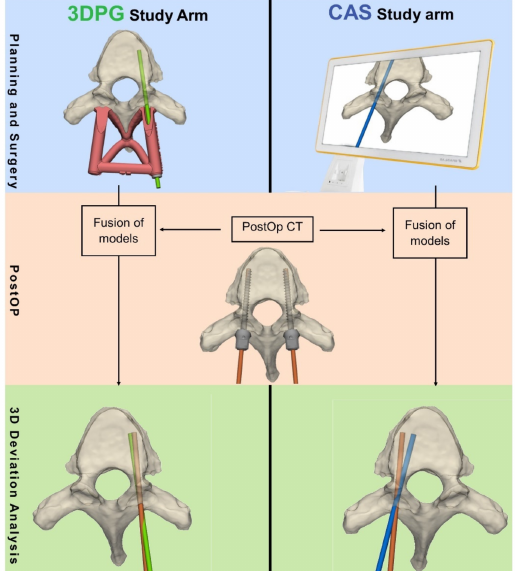
Figure 3. Schematic overview of the study depicting preoperative planning, preoperative measure- ments, and postoperative assessment procedures. 3DPG: 3D printed guides; CAS: Computer assisted surgery; 3D: 3 dimensional; PostOp CT: postoperative